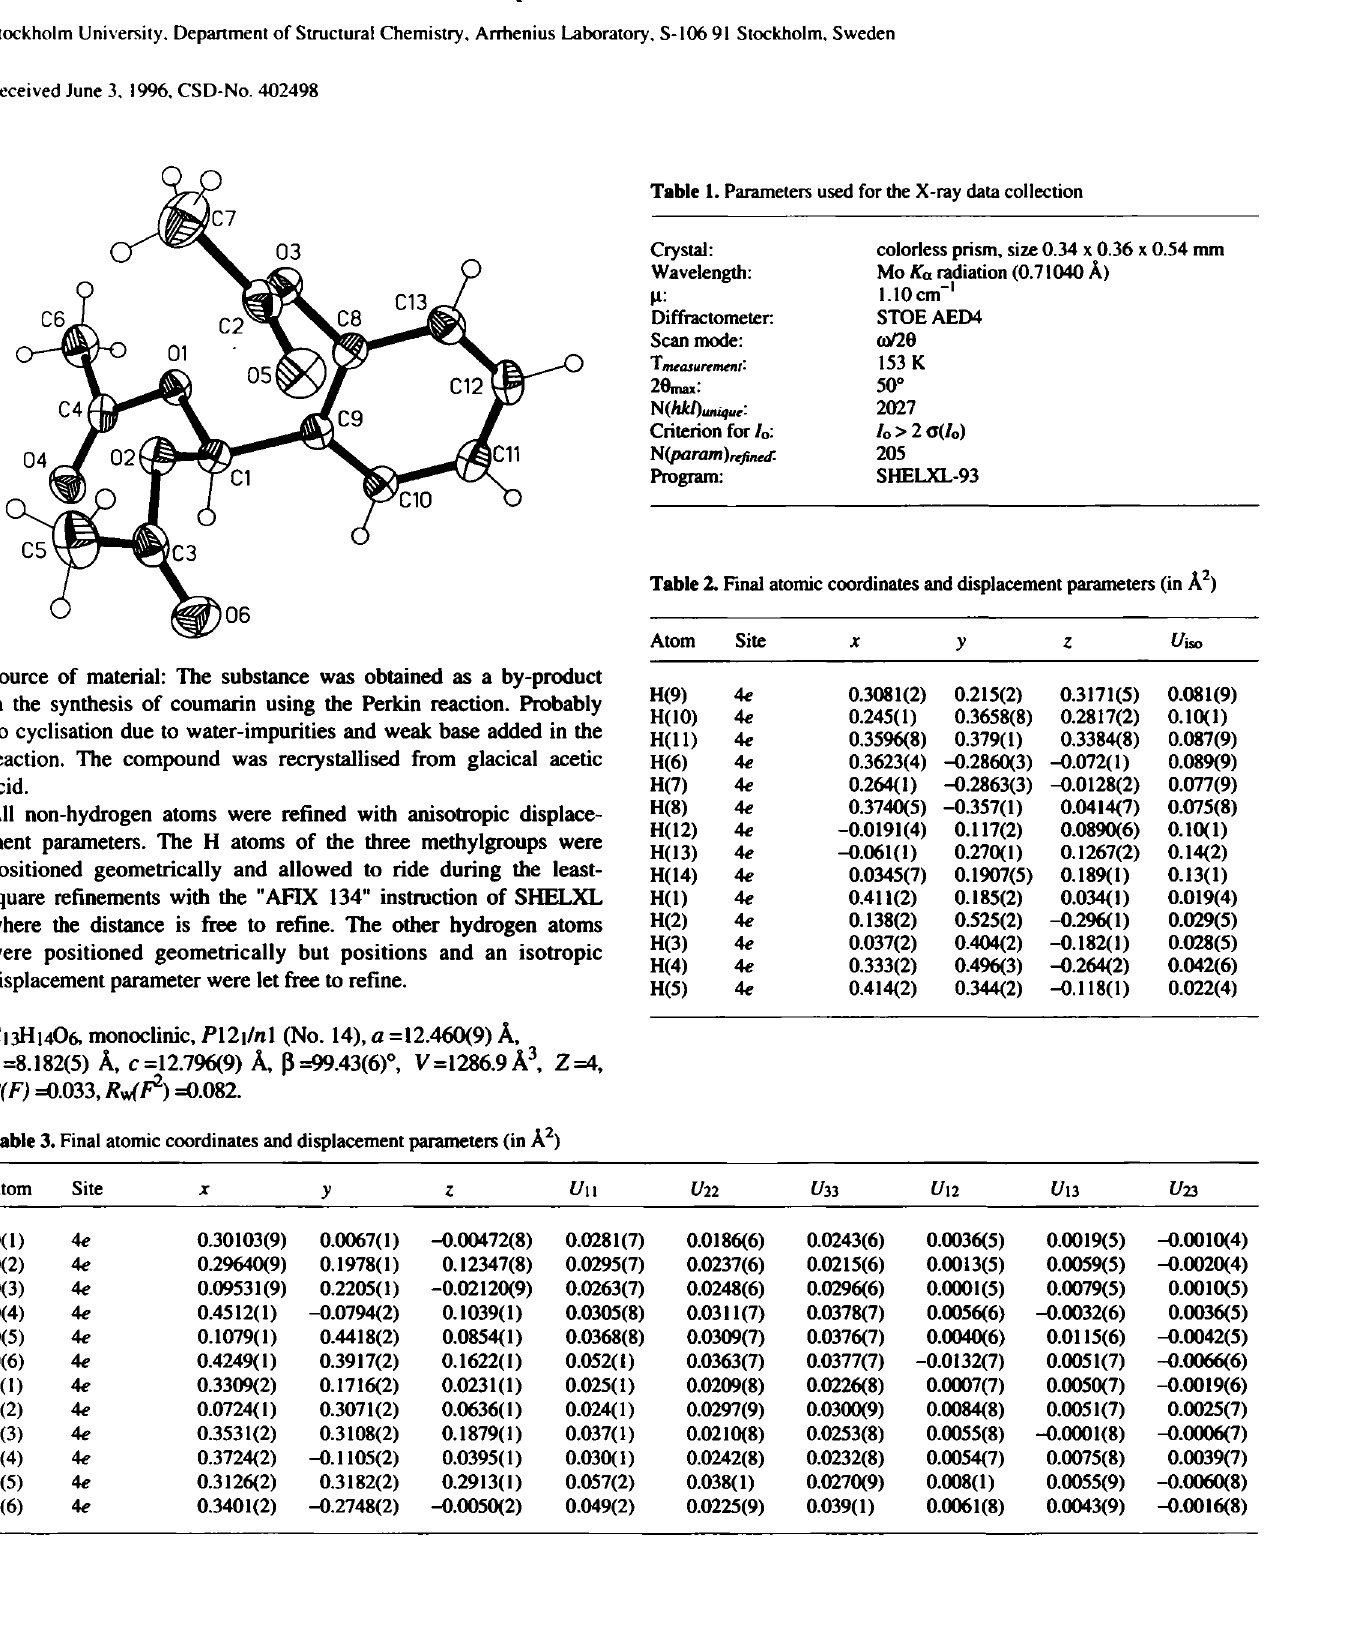
Table 1. Parameters used for the X-ray data collection